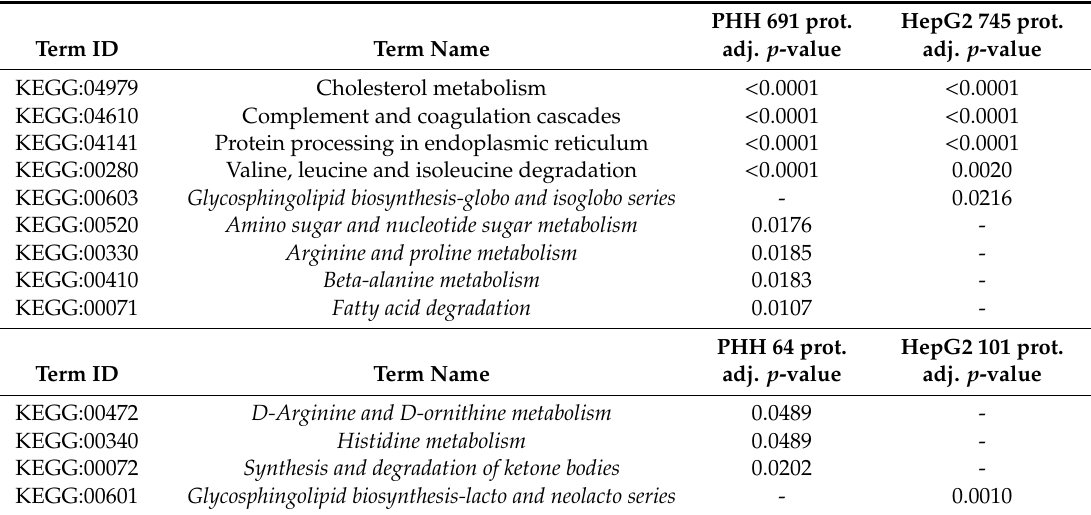
Table 4. Pathway enrichment of PHH and HepG2